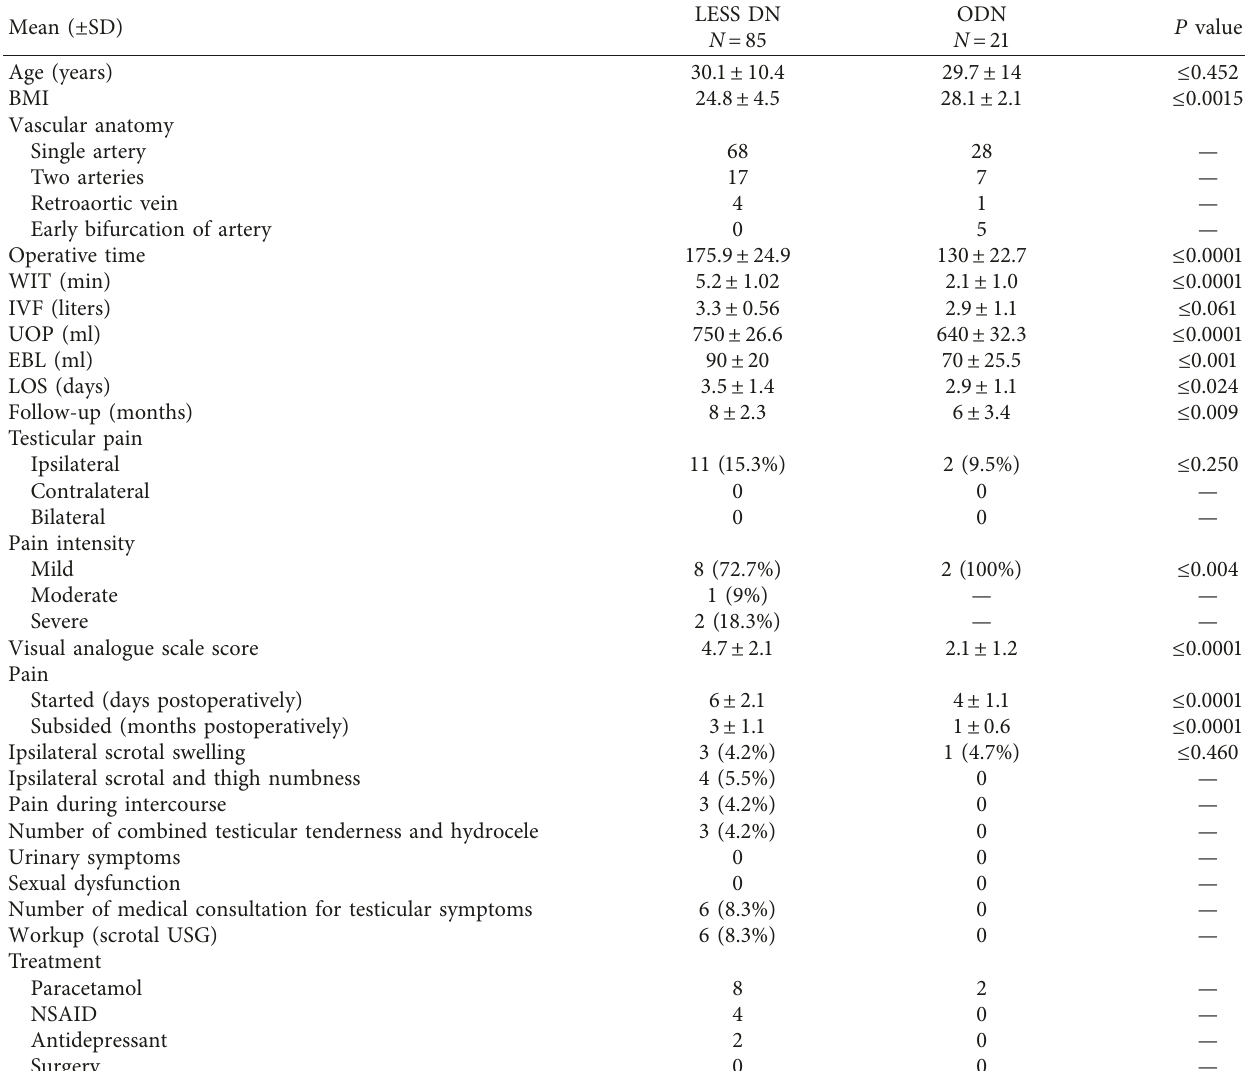
Table 1: Patients’ characteristics and perioperative